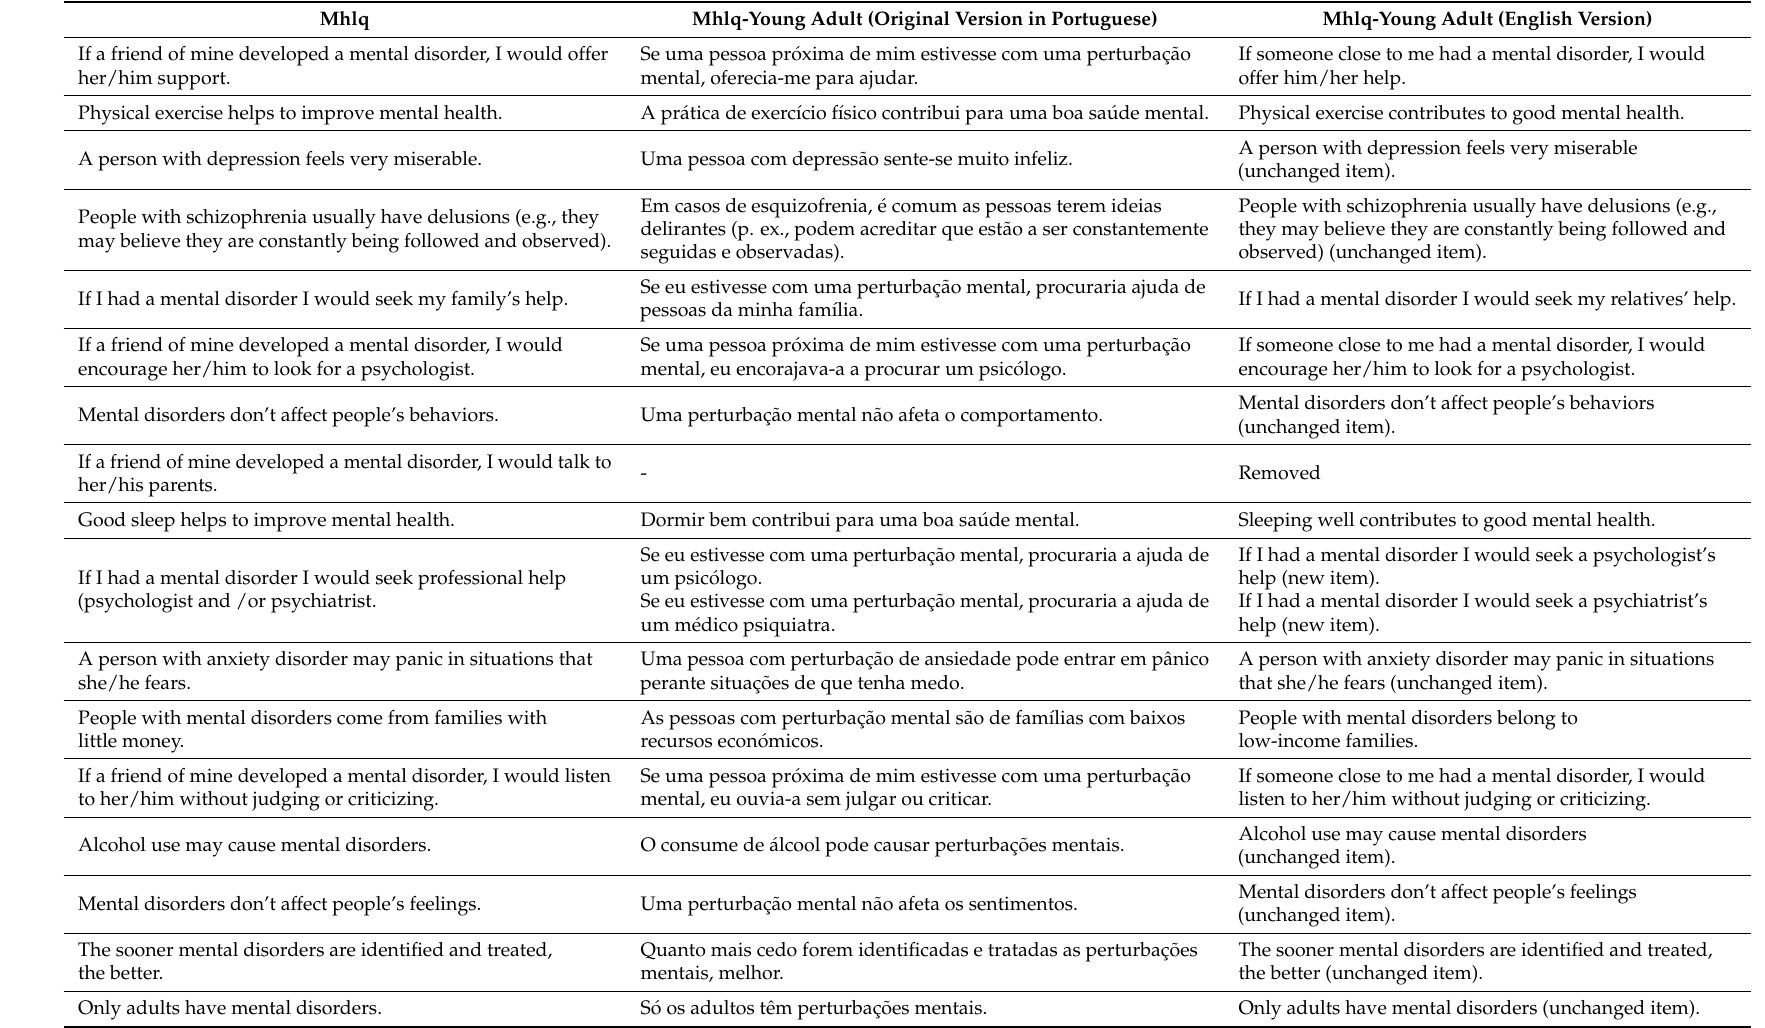
Table 1. MHLq items, MHLq-young adult version Portuguese and English